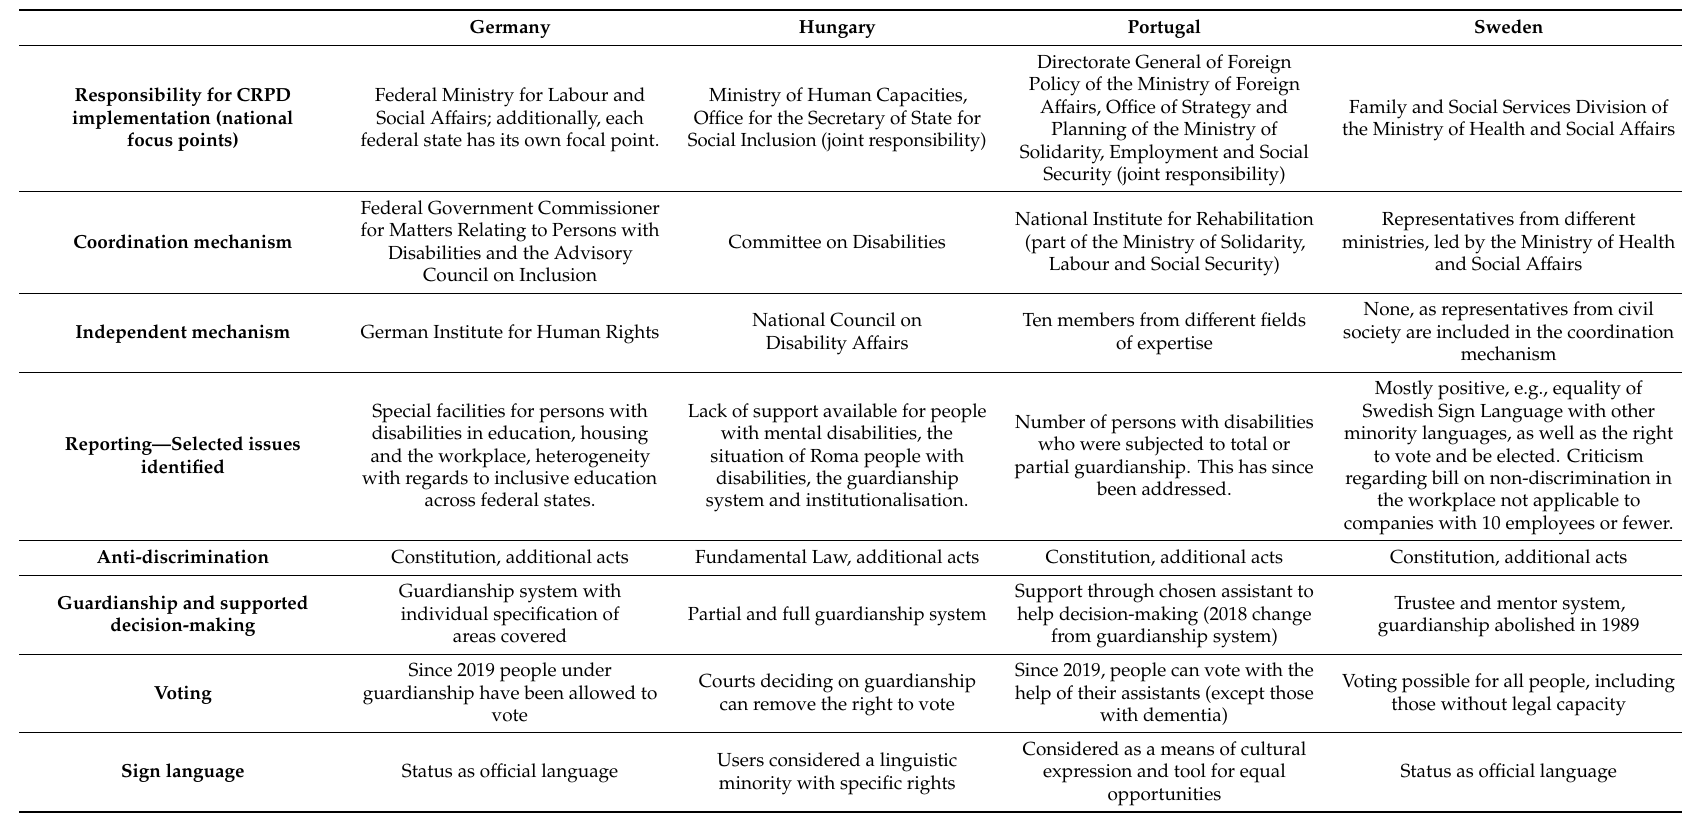
Table A1. Summary of Country